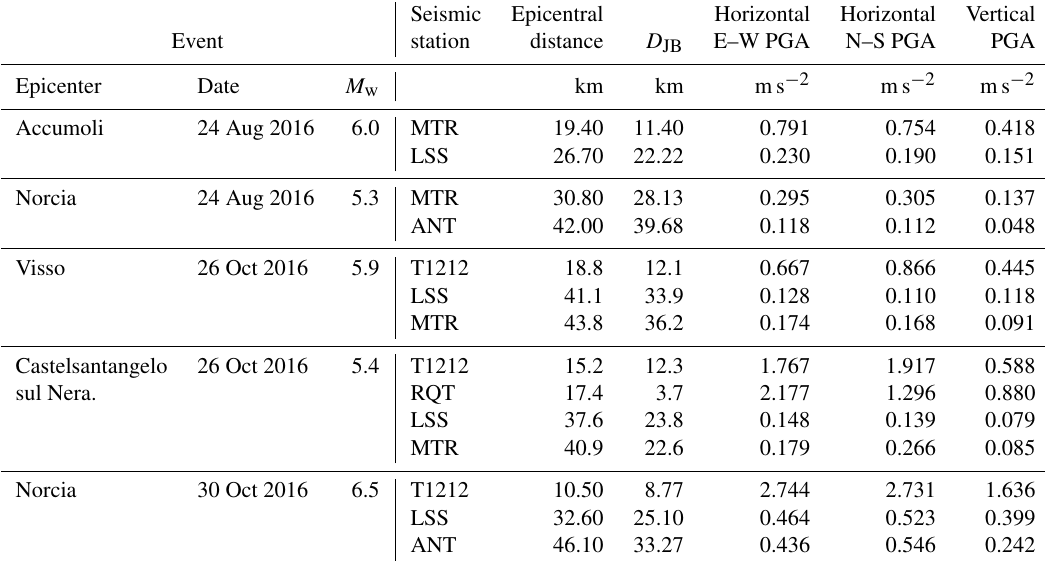
Table 2. Peak ground accelerations from the available records of the shocks at stations installed on rigid outcrop within 50km from the epicenters of the seismic events.